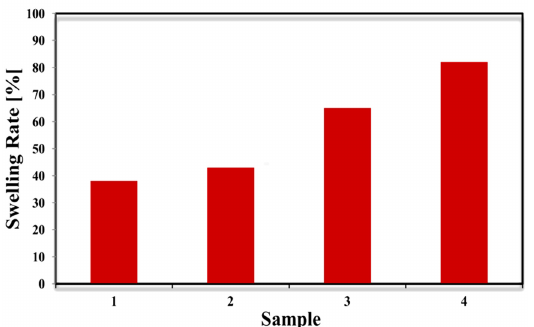
Fig. 5. Scaffold water absorption of nanofibers:(1) CS/PEO,(2) nanofibers containing 0.4%wt tetracycline, (3)nanofibers containing 0.6%wt tetracycline,(4) nanofibers containing 0.8%wt